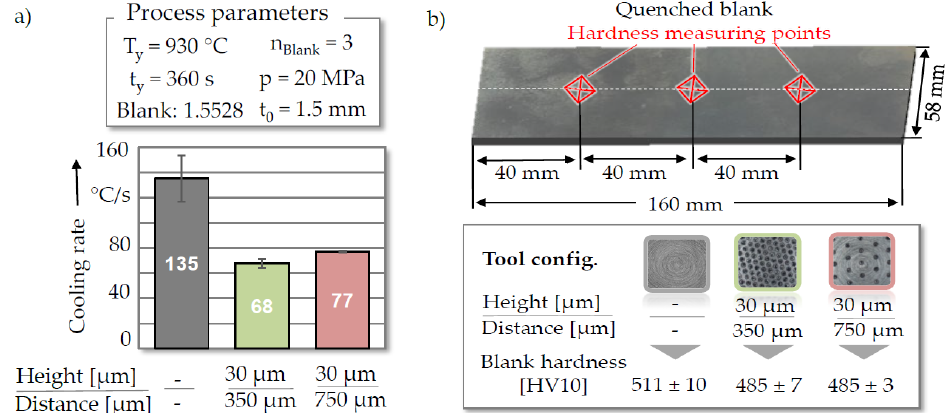
Figure 17. ( a ) Calculated cooling rates and ( b ) corresponding hardness of the quenched blanks.